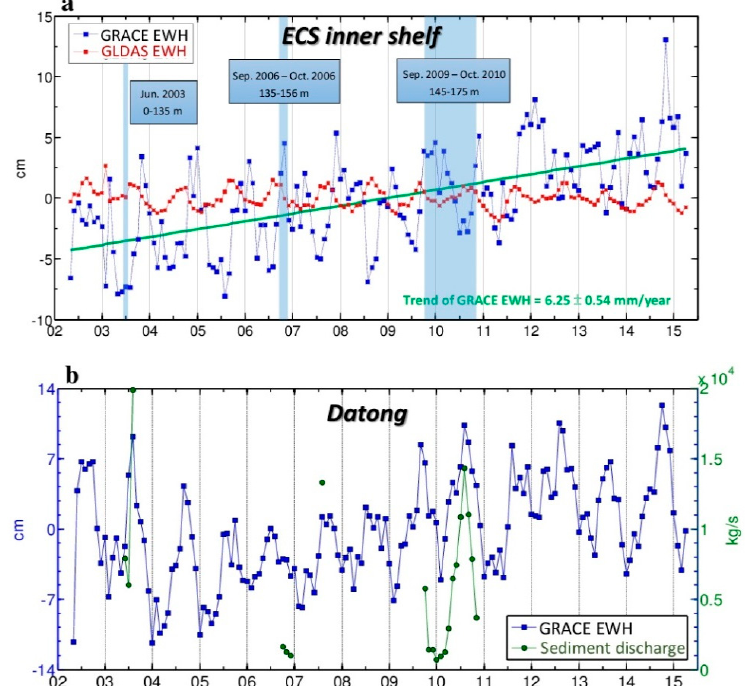
Figure 7. EWHs from GRACE and comparison with the sediment discharge of Yangtze. ( a ) EWHs on the ECS inner shelf from mean GRACE products and GLDAS; ( b ) Comparison between measured sediment discharges of the Yangtze River at the Datong hydrographic station and GRACE-derived EWHs around this station. The shaded periods mark the time periods of impoundments of the Three Gorge Dam (TGD). In June 2003, the TGD water level was raised to 135 m above sea level, followed by the rise to 156 m in late October 2006 and, finally, to 175 m in late October 2010.